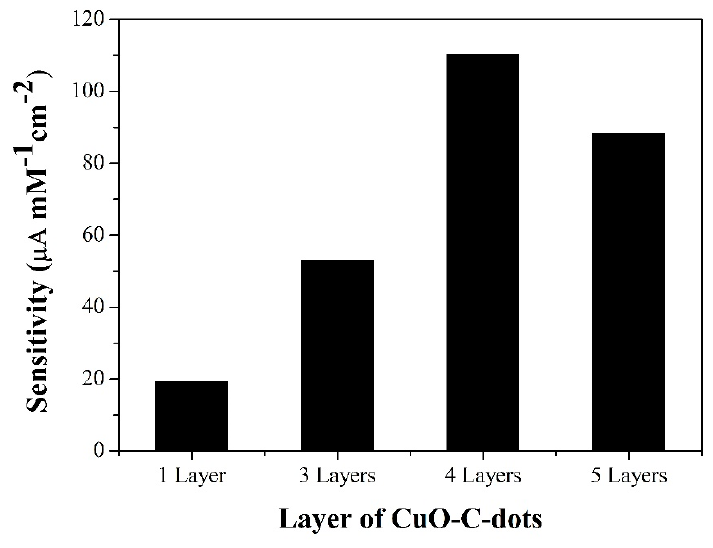
Figure 6. Sensitivity of the electrode achieved with different layers of CuO-C-dots on SPCE for glucose determination in 0.1 M NaOH.